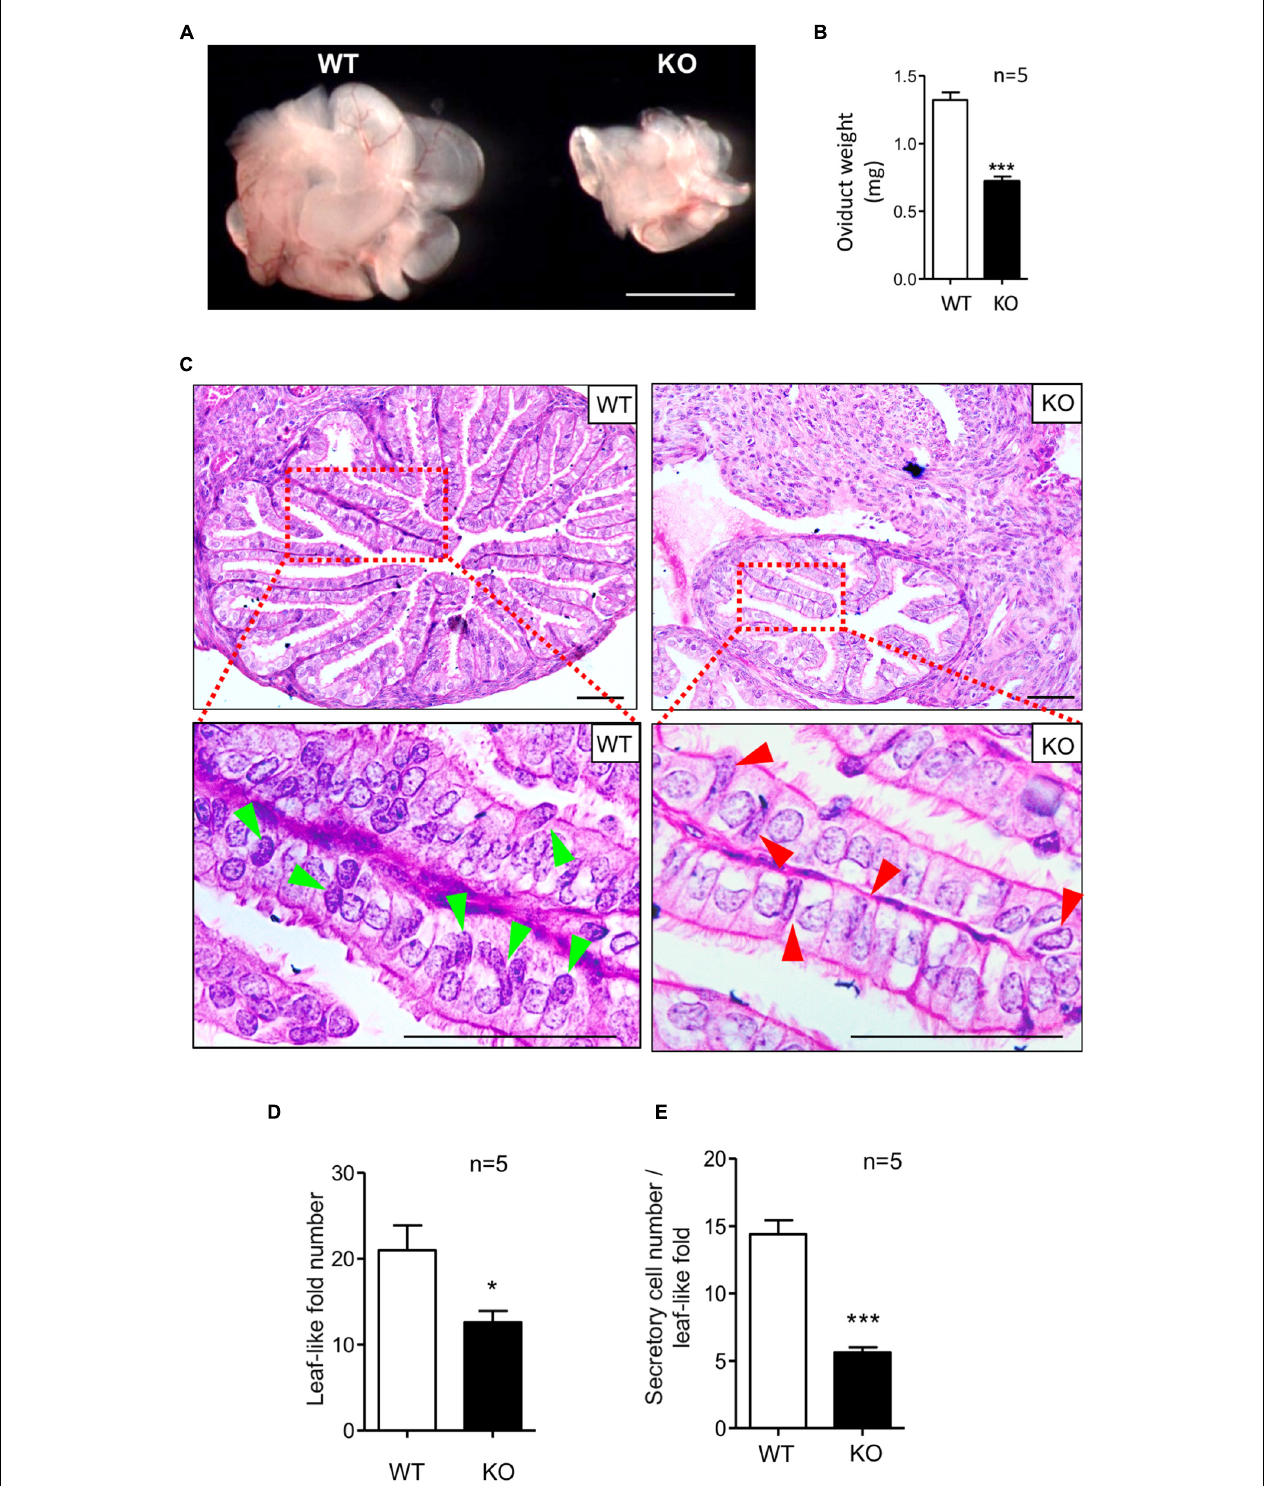
FIGURE 2 | Defects of oviducts in response to Lgr4 knockout. (A) Morphology of oviducts. (B) The mean weights of the Lgr4 knockout and WT mouse adult oviducts. (C) Histology of the WT and Lgr4 KO oviducts was determined by hematoxylin and eosin staining. The red boxed areas are shown at higher magnification beneath. (D) The number of the leaf-like folds. (E) The number of the secretory cells per leaf-like folds. * p ≤ 0.05; *** p ≤ 0.001. Scale bar, 1,000 µ m in (A) ; 50 µ m in (C) .